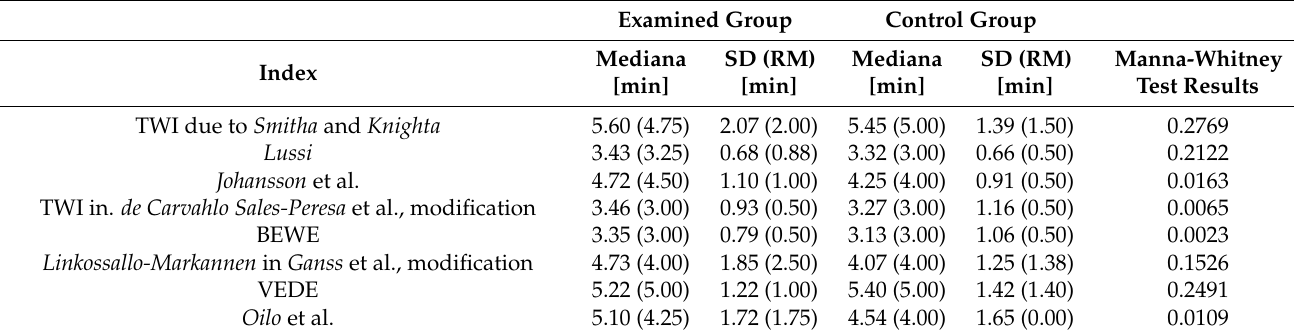
Figure 2. The result of the Friedman test in the assessment of the significance of the differences in the test time using individual wear/erosion indexes in the control group.